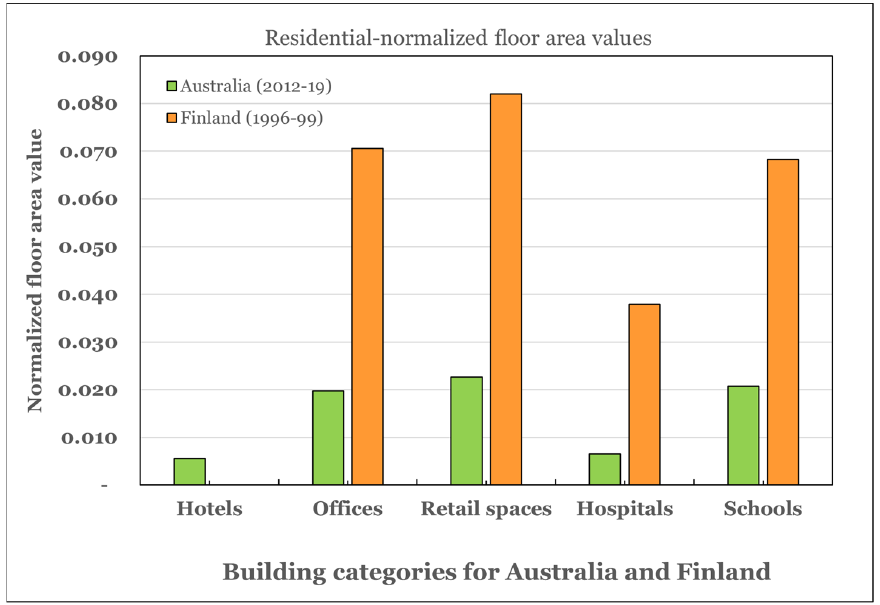
Figure 4. Normalized values of floor area in Australia compared to Finland (reference value: residential area).